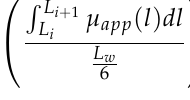
Figure 6. Comparison of magnetic field collection capacity of three core structures.